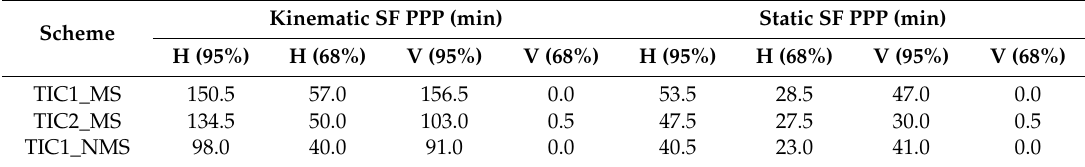
Table 2. The convergence times of GPS static and kinematic SF PPP in MS and NMS of TIC1 or TIC2. Scheme